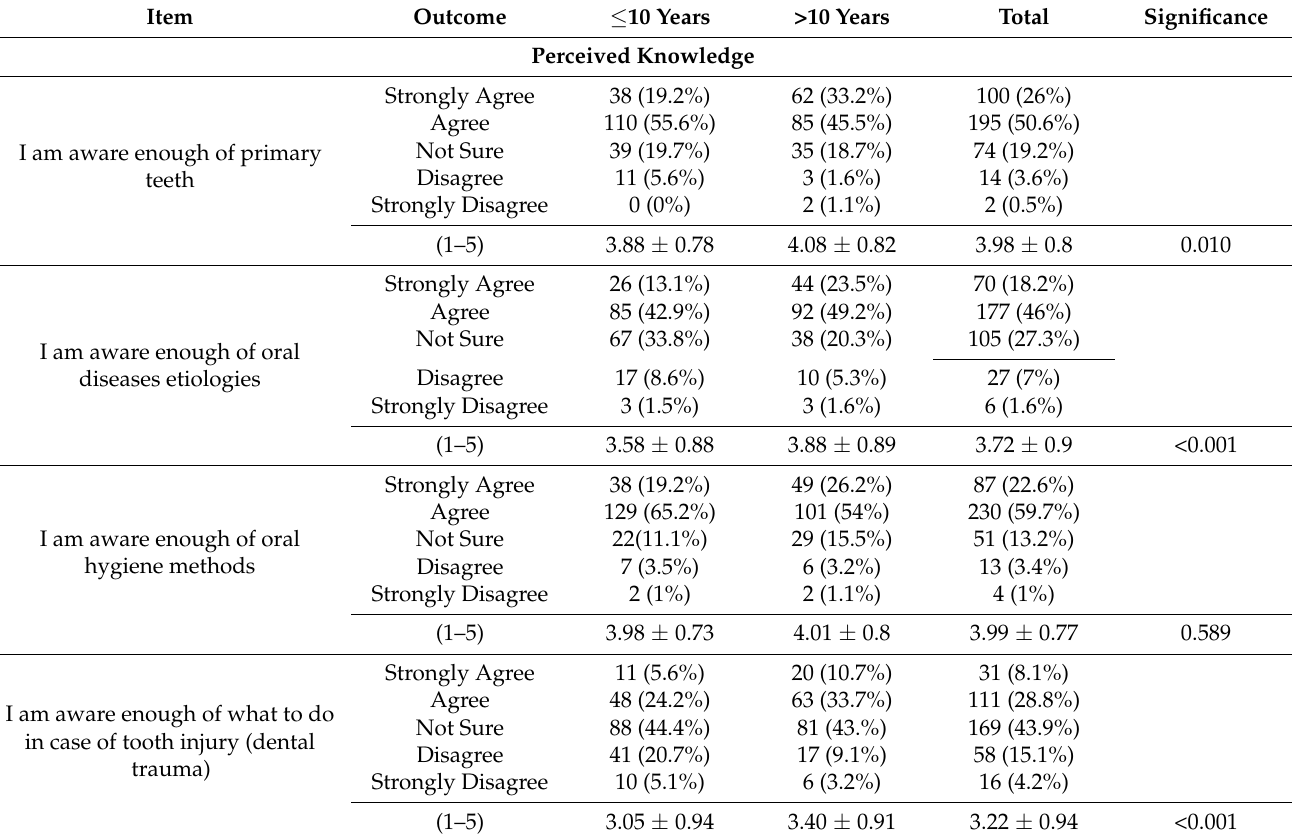
Table 2. Oral health-related knowledge of elementary schoolteachers stratified by work experience, Istanbul, Turkey, 2020.